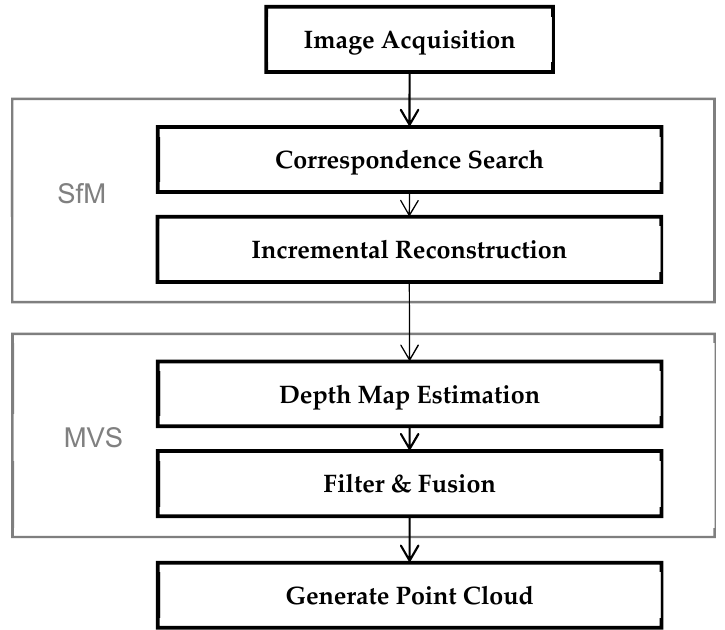
Figure 5. The pipeline of SfM–MVS reconstruction.